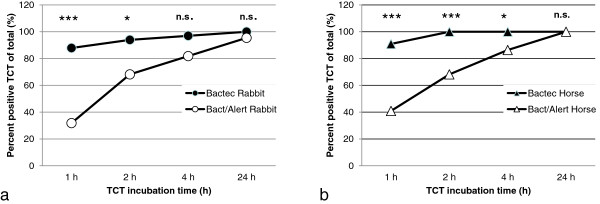
The rapidity of positive tube coagulase test (TCT) differs between blood culture systems.S. aureus-inoculated bottles were incubated in BACTEC (filled symbols) and BacT/Alert (empty symbols) respectively and when signalling positive were analysed for time to positivity in the TCT. The results using rabbit plasma is shown in Figure 
4a and horse plasma in Figure 
4b. Statistics were performed using Chi square tests comparing Bactec and BacT/Alert blood culturing systems. Significance levels are shown as stars (p < 0.001 = ***, p < 0.01 = **, p < 0.05 = *, n.s. = non-significant).